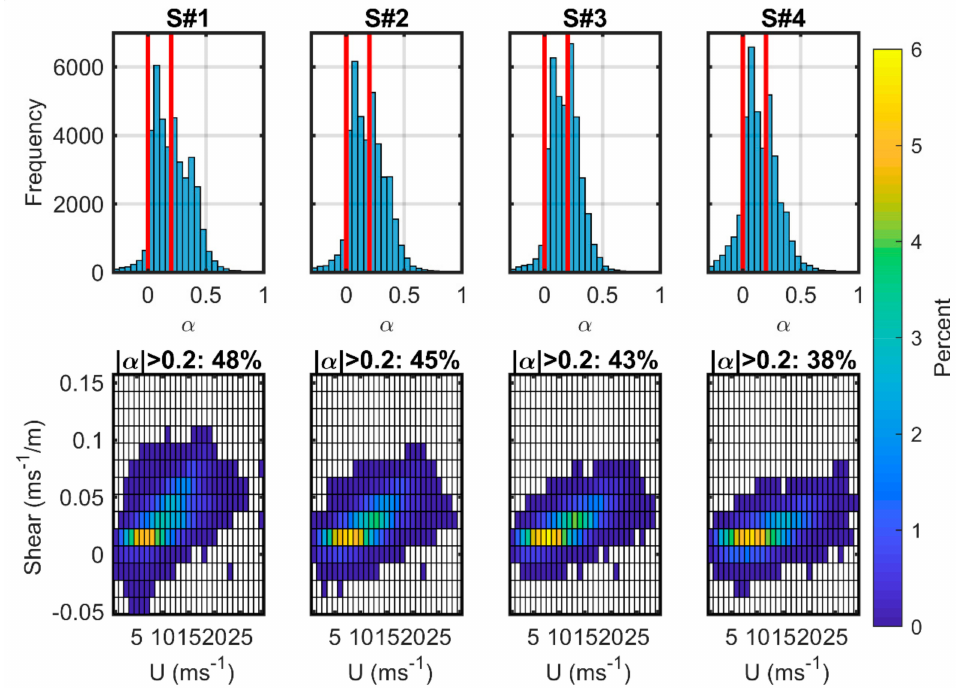
Figure 11. Analysis of shear from site 1. The top sub-panels show a histogram of the 10-min values of shear exponent α computed for the heights across the rotor plane for each WT scenario. The red lines indicate the two thresholds for shear exponent employed herein: α = 0 and 0.2. The bottom sub-panels show the joint probability distribution of the 10-min values of shear magnitude across the rotor plane and hub-height wind speed for each WT scenario. The title above each of these frames indicate the fraction of 10-min periods when the absolute value of α exceeded